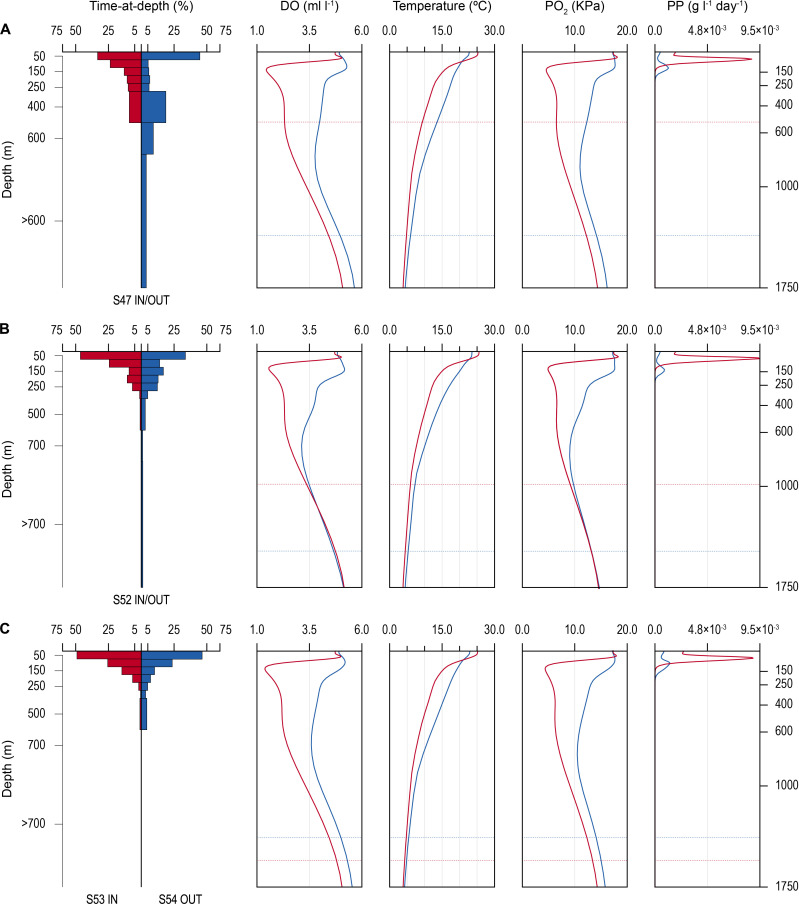
Time-at-depth of blue sharks in oxygen minimum zone (OMZ) and adjacent areas in relation to environmental variables.Vertical depth use ratio (left panel) between waters above the OMZ (red) and adjacent waters outside the area of OMZ (blue) for sharks 47 and 52 (A and B); depth use ratio comparing depth distributions of shark 53 above the OMZ with shark 54 outside the area above the OMZ (C). In A–C, the panels on the right show the average dissolved oxygen (DO) concentration, water temperature, pO2, and net primary production (NPP) concentration between the surface and 1750 m, and horizontal dotted lines denote the MDD depth of each shark recorded inside (red) and outside (blue) the OMZ area.